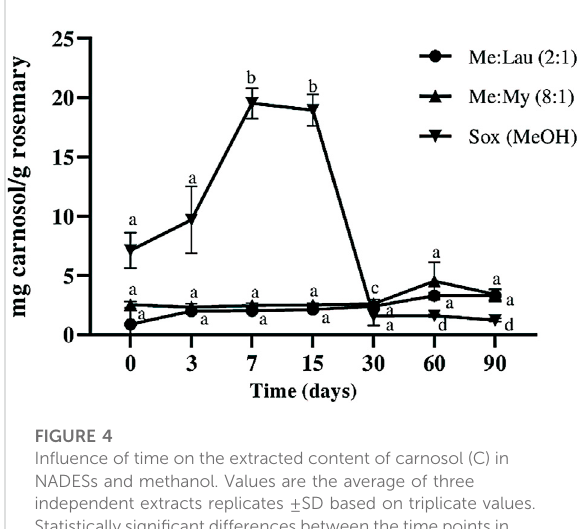
FIGURE 6 In fl uence of time on the extracted content of caffeic acid in NADESs and methanol. Values are the averages of three independent extract replicates ±SD based on triplicate values. Statistically signi fi cant differences between the time points in each system are represented by letters. Different letters indicate signi fi cant differences within each